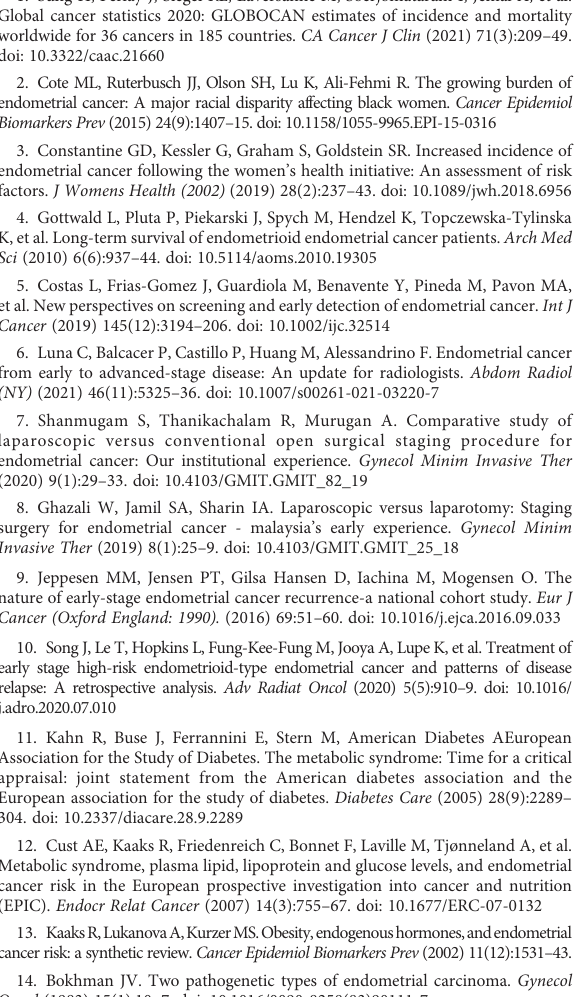
SUPPLEMENTARY FIGURE 3 Kaplan-Meier curves of overall survival by subtypes of metabolic syndrome. Raised FPG involved MetS refers to MetS diagnosed according to the new International Diabetes Federation (IDF) de fi nition and the patients were with the factor “ raised FPG ” which weredetermined by FPG ≥ 5.6 mmol/L and/or HbA1c ≥ 6.5%. The rest of the MetS patients were categorized as FPG not involved MetS. MetS, metabolic syndrome; FPG, fasting plasma